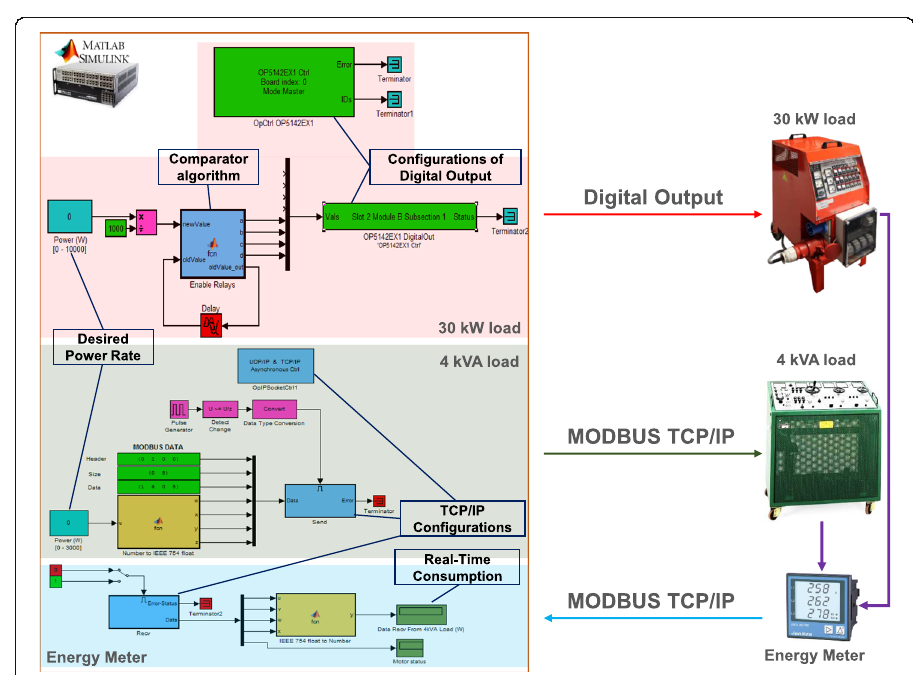
Fig. 3 Simulink HIL models for consumption of prosumer in BUS #15